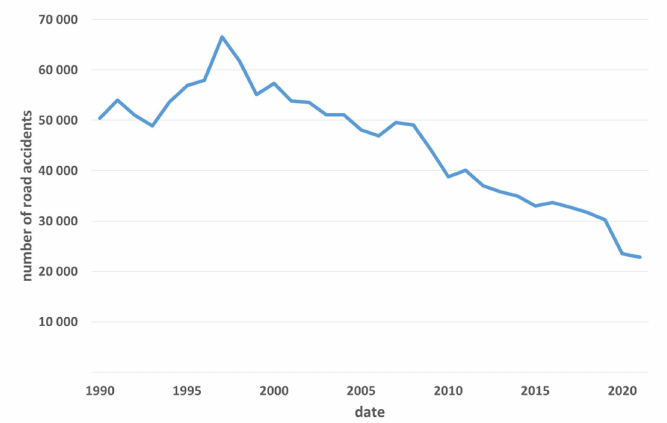
Figure 1. Number of road accidents in Poland between 1990 and 2021